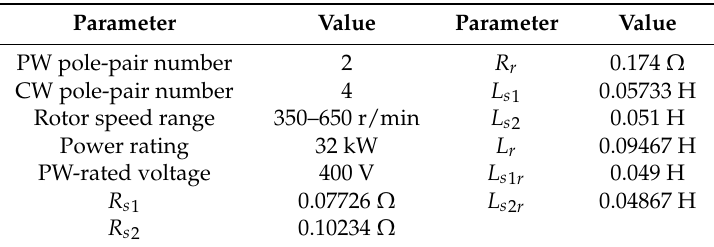
Table 1. The specifications of the BDFIG